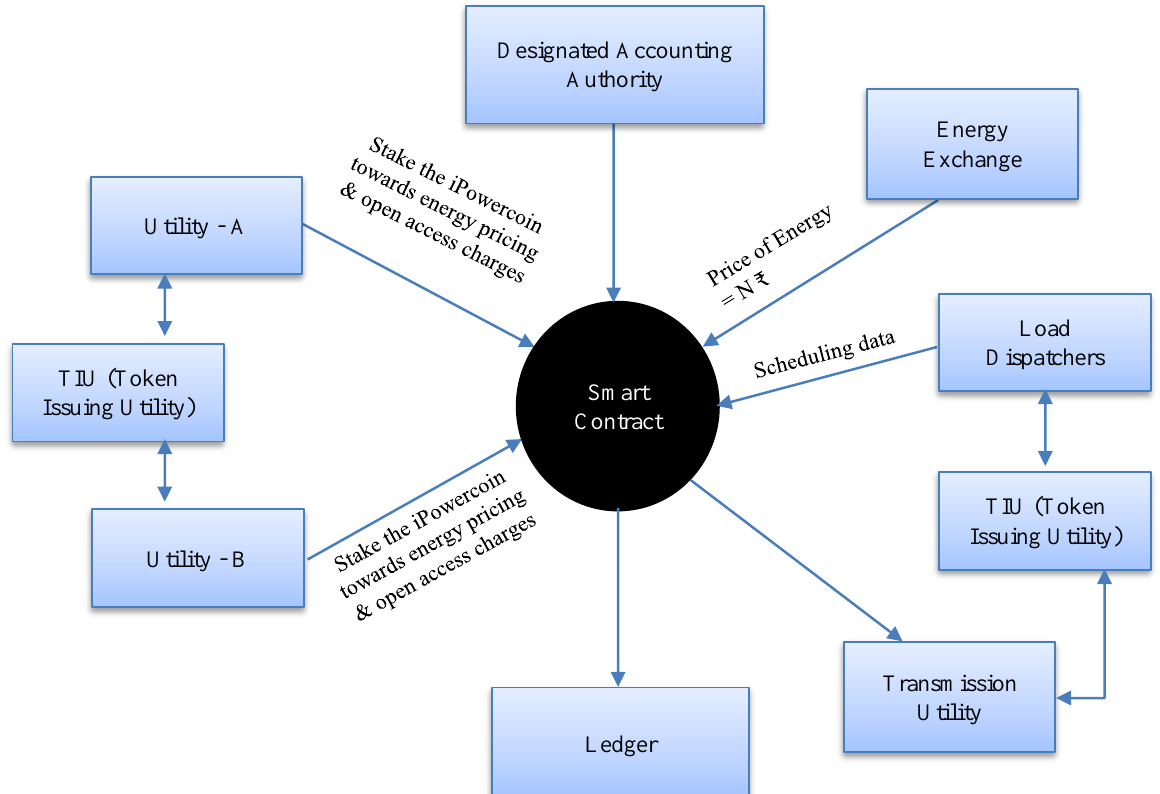
Figure 5. Block diagram for the proposed model of Energy